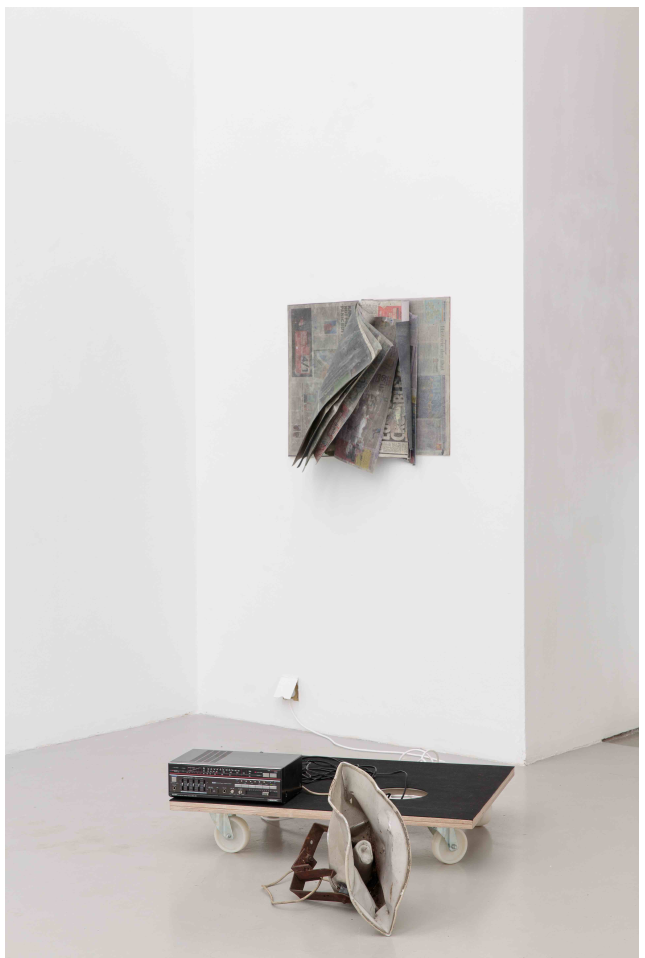
Figure 1: Robert Rivers, Time Painting—paper , 2016, Glow in the dark paint, paper, canvas, aluminium, 56 x 77cm. Exhibited alongside Time Painting—sound , 2016, Found